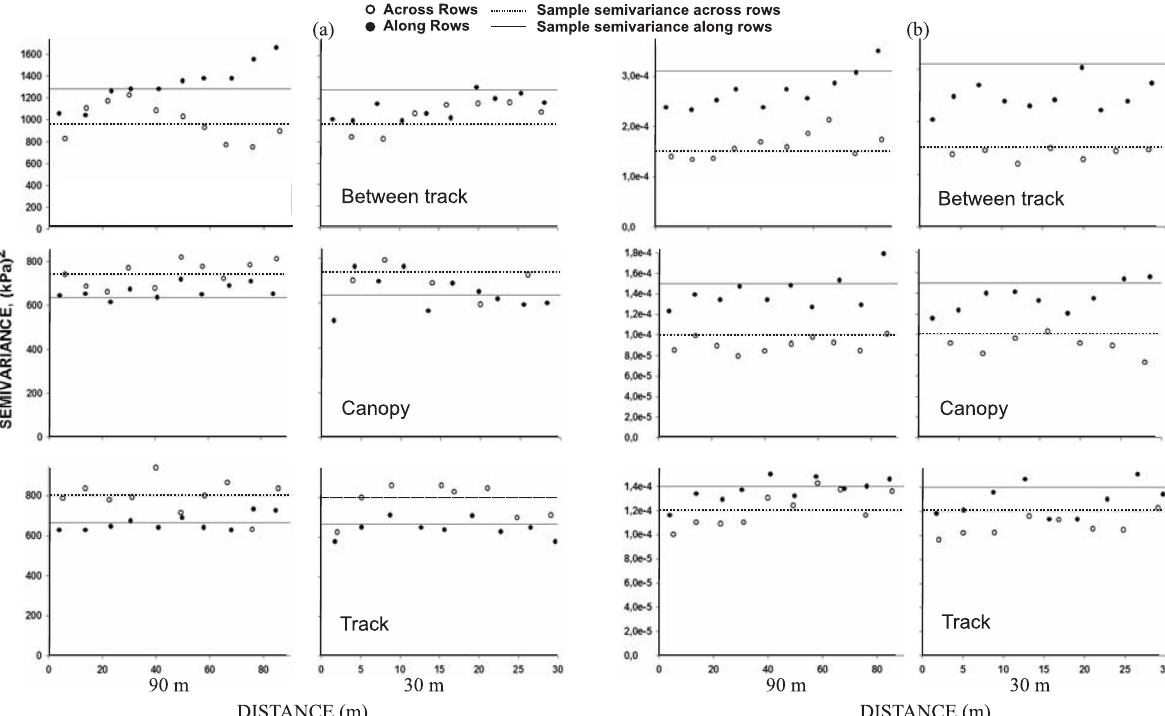
Figure 4. Experimental semivariograms for preconsolidation pressure (a) and soil moisture (b), for all sites and both